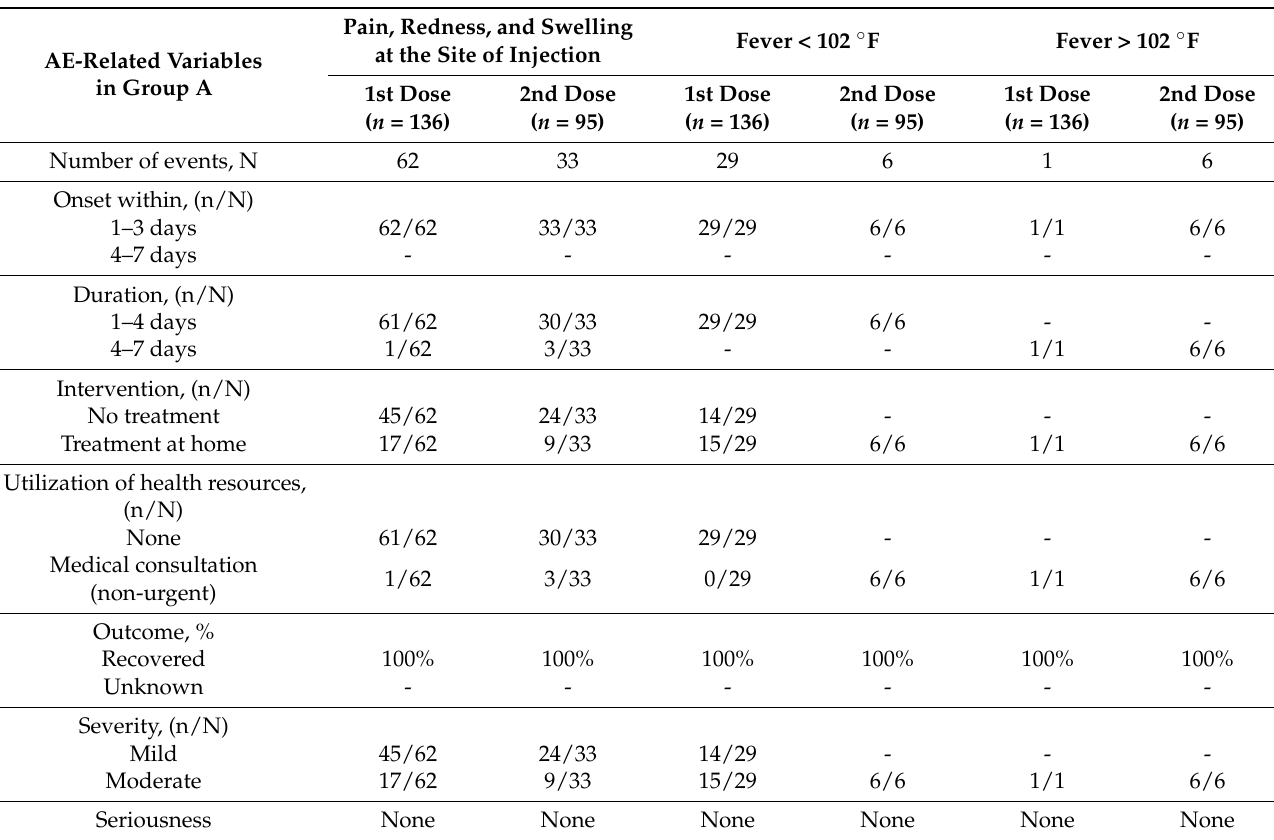
Table 4. Description of adverse event (AE)-related variables after first and second dose of m-RNA COVID-19 vaccine in group A (5–11